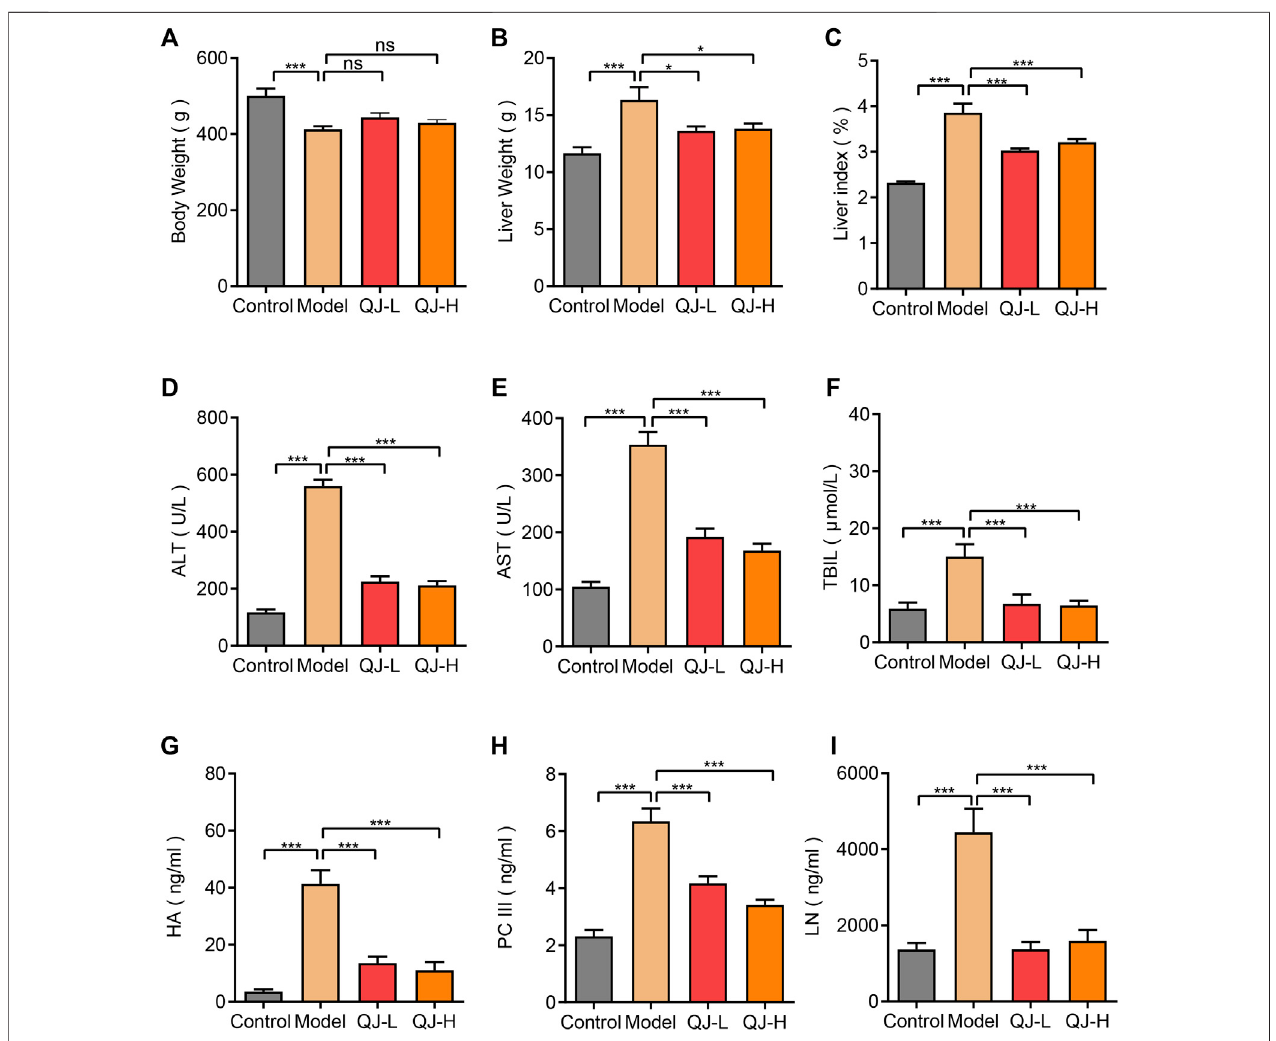
FIGURE2| Detectionofliverindexandserumbiochemicalindicatorsofratsinfourgroups. (A) Bodyweight( n =8 – 16); (B) Liverweight( n =8 – 16); (C) Liverindex= Liver weight/Body weight X 100% ( n = 8 – 16); (D) ALT: alanine aminotransferase ( n = 8 – 16); (E) AST: aspartate aminotransferase ( n = 8 – 16); (F) TBIL: total bilirubin ( n = 8 – 16); (G) HA: hyaluronic acid ( n = 8 – 10); (H) PC III: type III procollagen ( n = 8 – 10); (I) LN: laminin ( n = 8 – 10). * p < 0.05 and *** p < 0.001. ns, not signi fi cant.